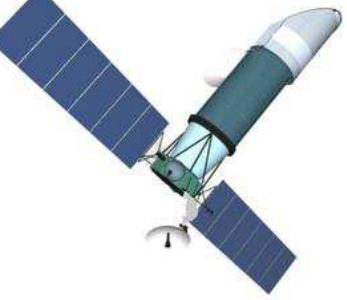
Figure 1: The WSO-UV Space